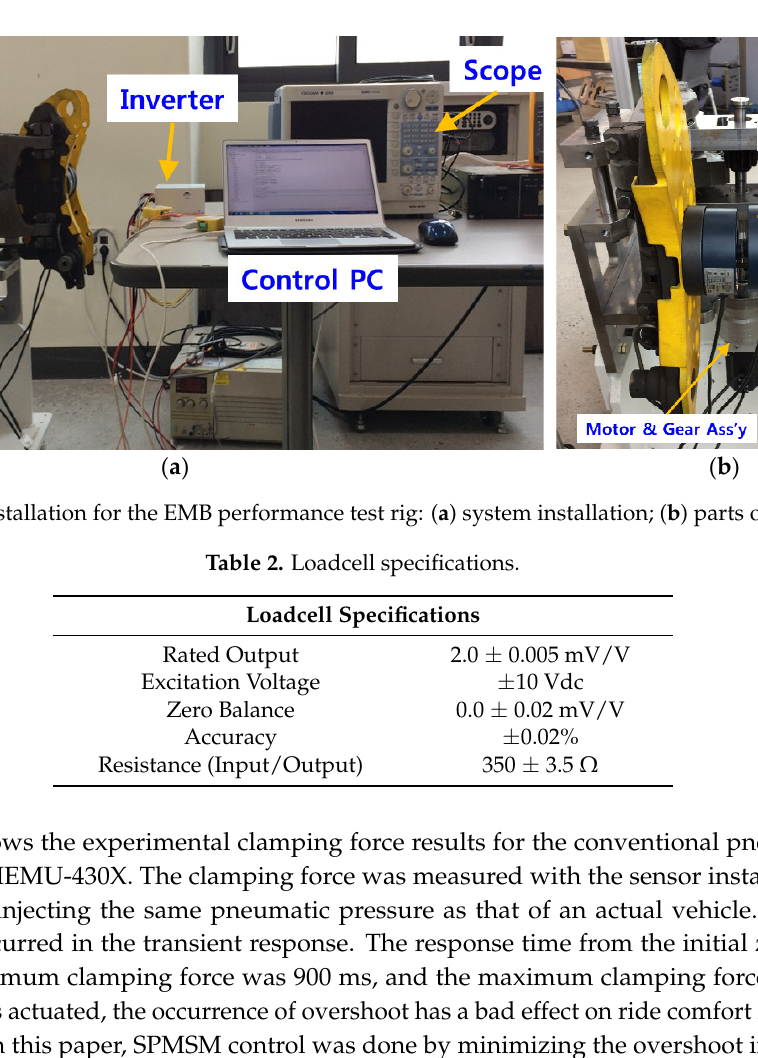
( b ) Figure 10. EMB experimental results: ( a ) clamping force; ( b ) response time of the clamping force.